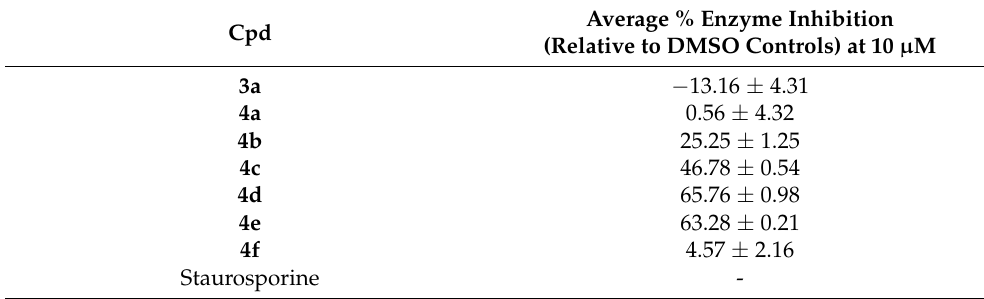
Table 5. % Inhibition values of the synthesized compounds 3a and 4a – f over EGFR kinase at a single dose concentration of 10 µM.